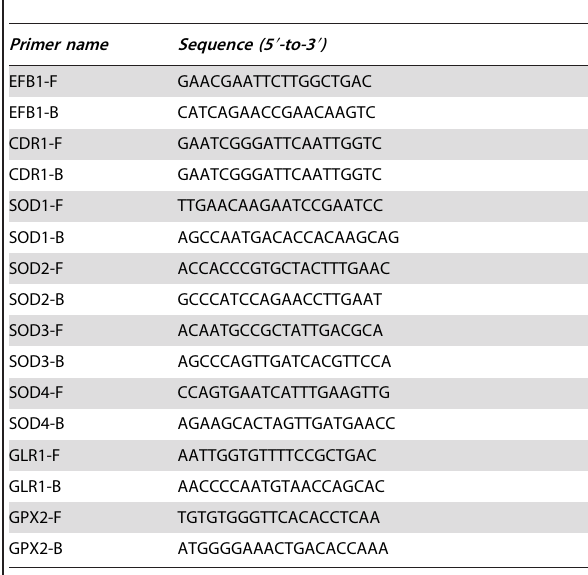
Table 2. Primer sequences used in